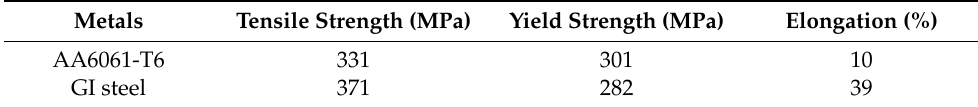
Table 2. Mechanical properties of AA6061-T6 and GI